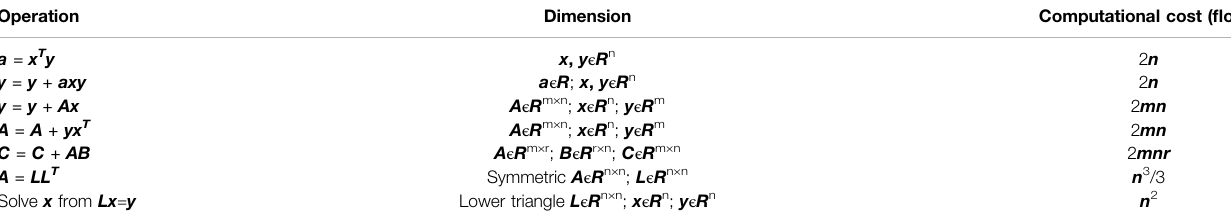
TABLE 1 | A summary of computational costs of commonly used algebraic operations. Operation Dimension Computational cost ( fl